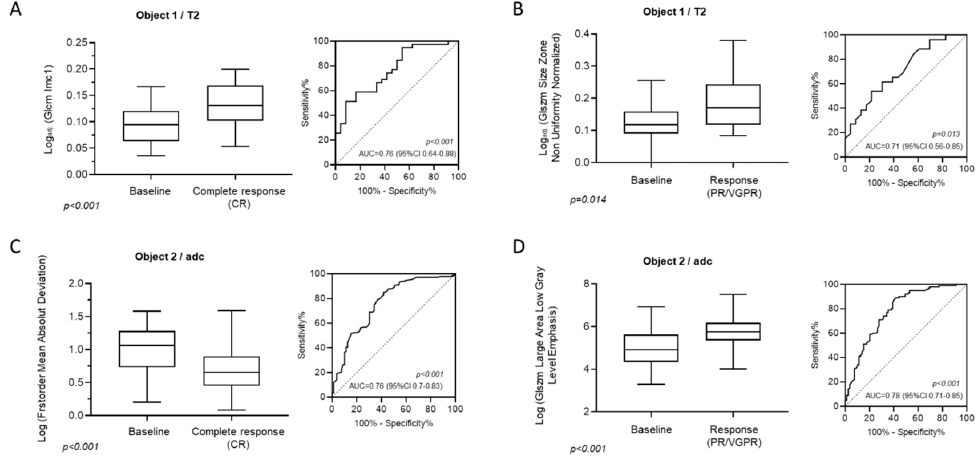
Figure 5. Box plots presenting the statistically significant textural features on STIR images both in focal ( A , B ) and di ff use marrow involvement ( C , D ) both for patients experiencing complete response ( A , C ) and very good partial response / partial response ( B , C ). The ROC analysis on the right illustrates the AUC, corresponding p -value and confidence interval for the log of the analyzed texture